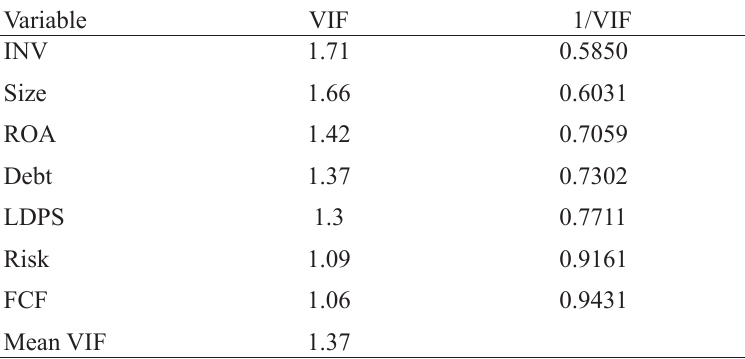
Variation Inflation Factor Analysis of Determinants of